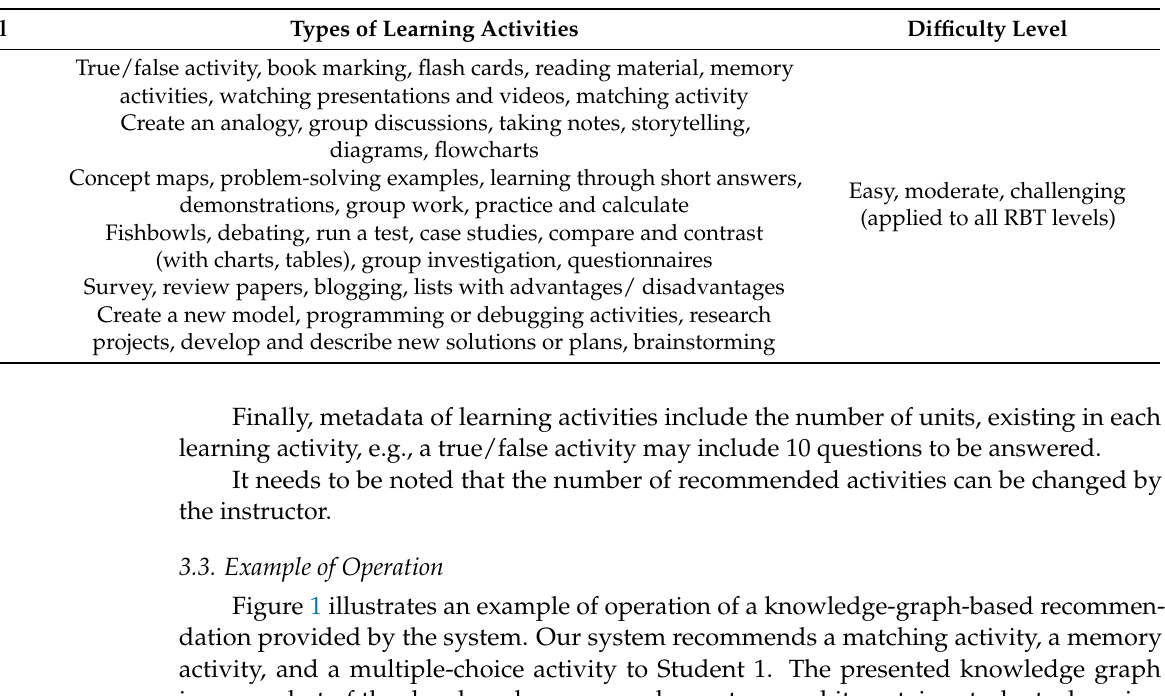
Table 1. RBT levels.